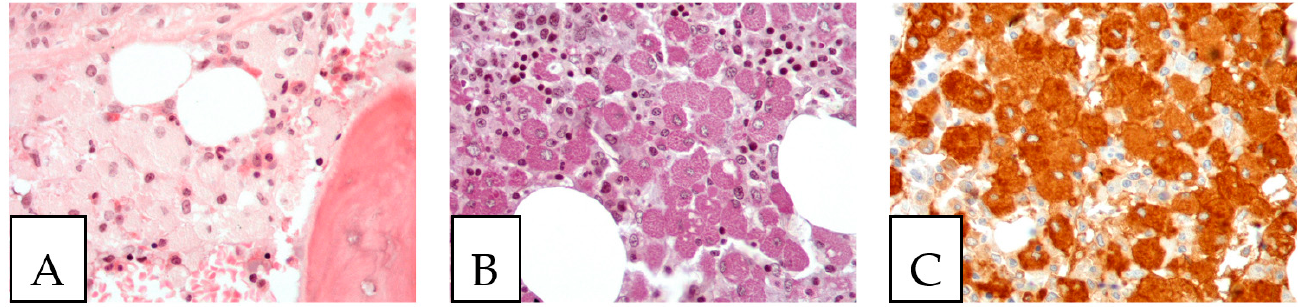
Figure 7. Gaucher disease. ( A ) . Bone marrow involvement, with histiocytes with an eosinophilic cytoplasm (Gaucher cells). ( B ) . PAS-positive histiocytes. ( C ) . CD68-positive histiocytes. The patient, a 52-year-old female, suffered from hepatosplenomegaly and anemia.